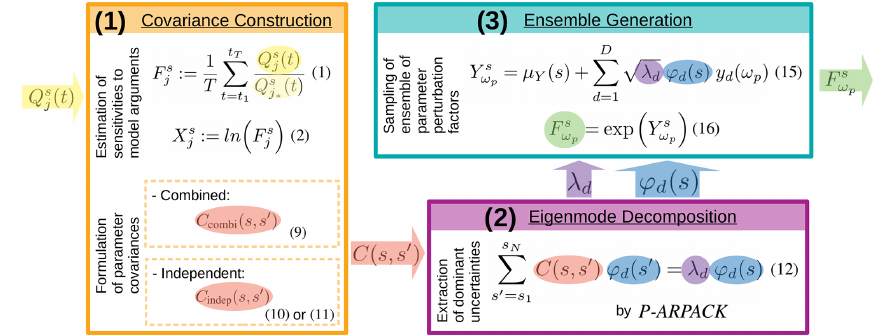
Figure 2. Simplified schematic overview of the KL ensemble generation algorithm. Equation numbers refer to the equations in Sects. 2 and 3. Colored arrows indicate input and output of the algorithm and the transfer of selected fields between the single